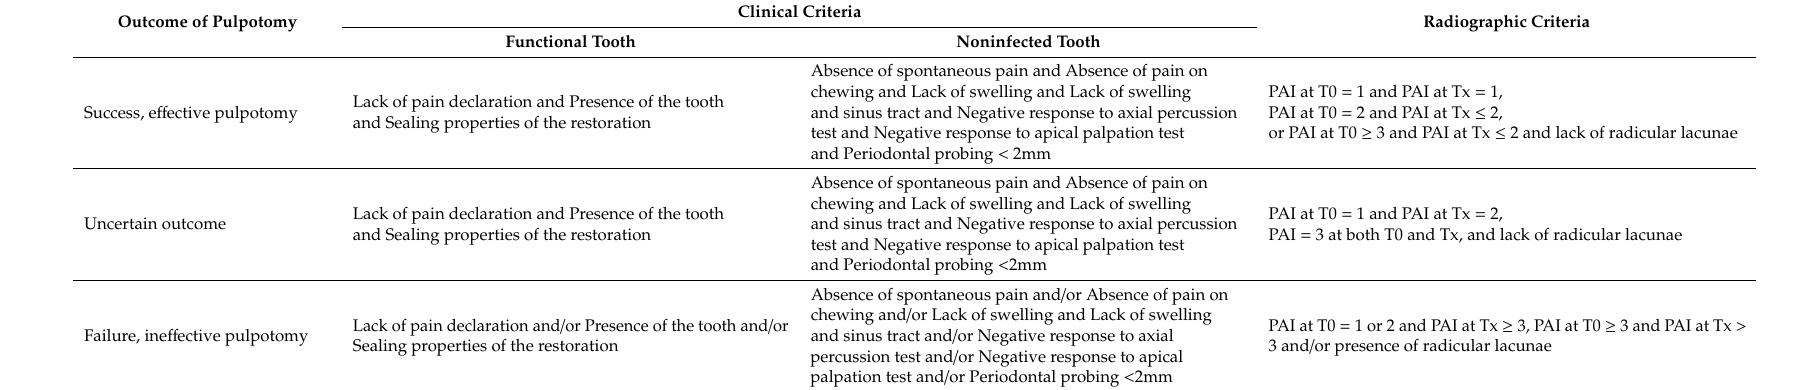
Table 2. Zanini et al. criteria for the evaluation of the outcome of